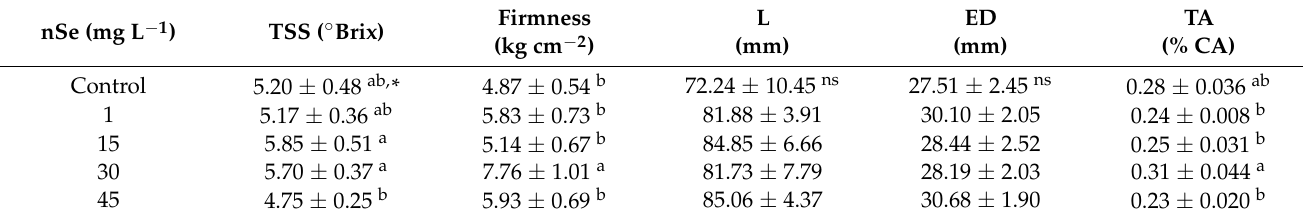
Table 2. Components of the fruit quality of Jalapeño pepper fruits.